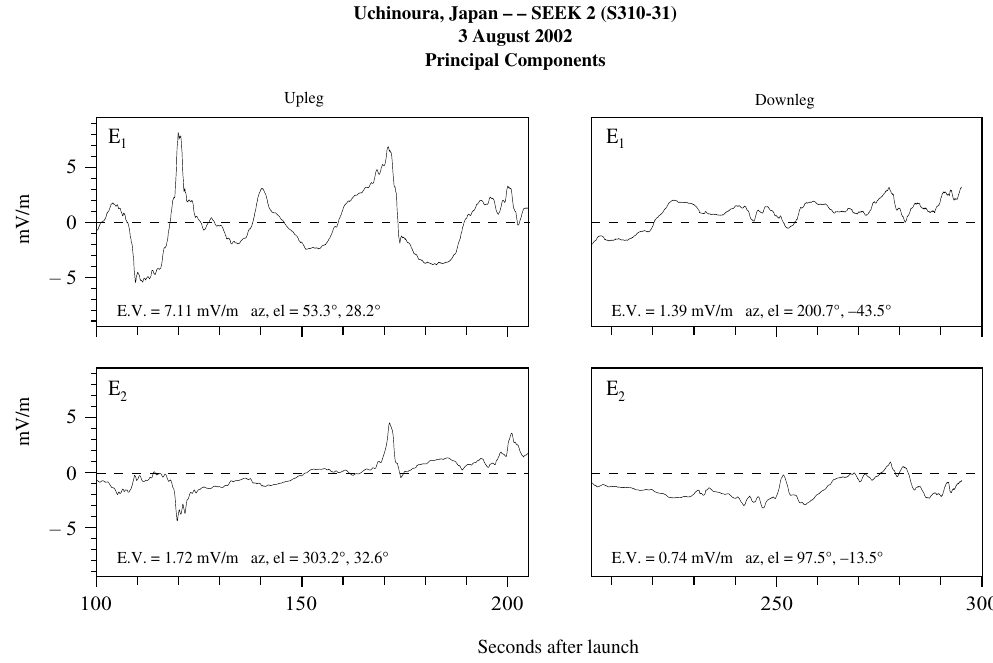
Fig. 10. Minimum variance solution for the upleg (left) and downleg (right) electric field structures above the sporadic- E layer ( > 110km). The solution provides the principal component (E 1 ) and secondary component (E 2 ) . The eigenvalues (E.V.) are noted in the lower left of the panels as well as the azimuth and elevation of each